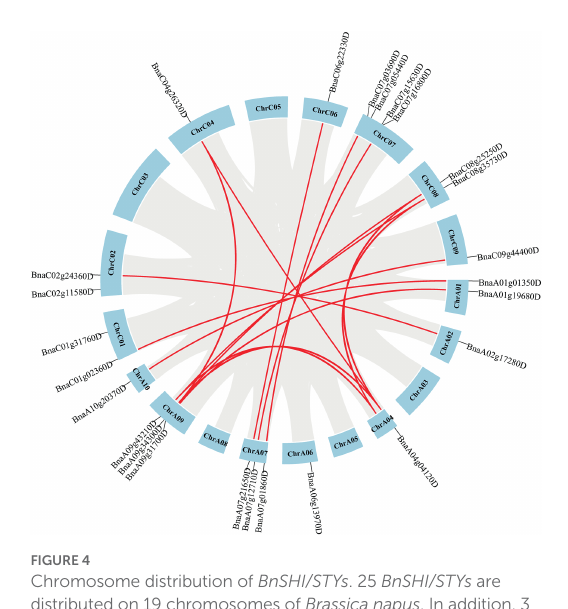
FIGURE 4 Chromosome distribution of BnSHI/STYs . 25 BnSHI/STYs are distributed on 19 chromosomes of Brassica napus . In addition, 3 BnSHI/STYs are not mapped to chromosomes. The duplicated BnSHI/STY gene pairs were indicated in red lines. The number of chromosomes is displayed on each chromosome.